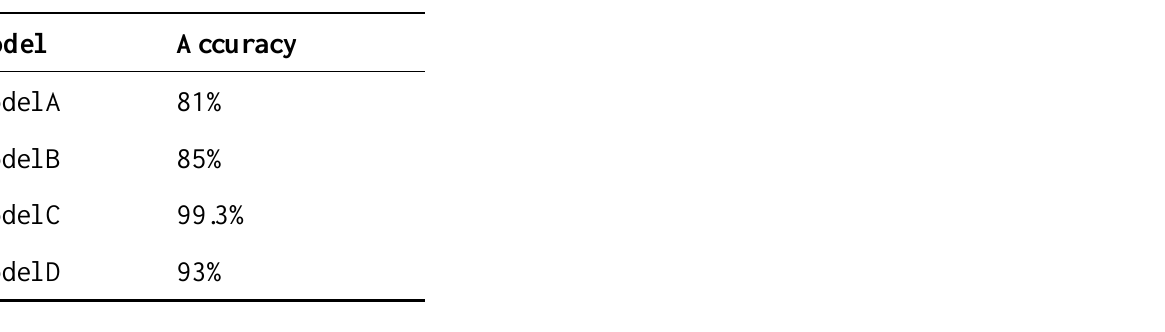
Table 3. Models developed